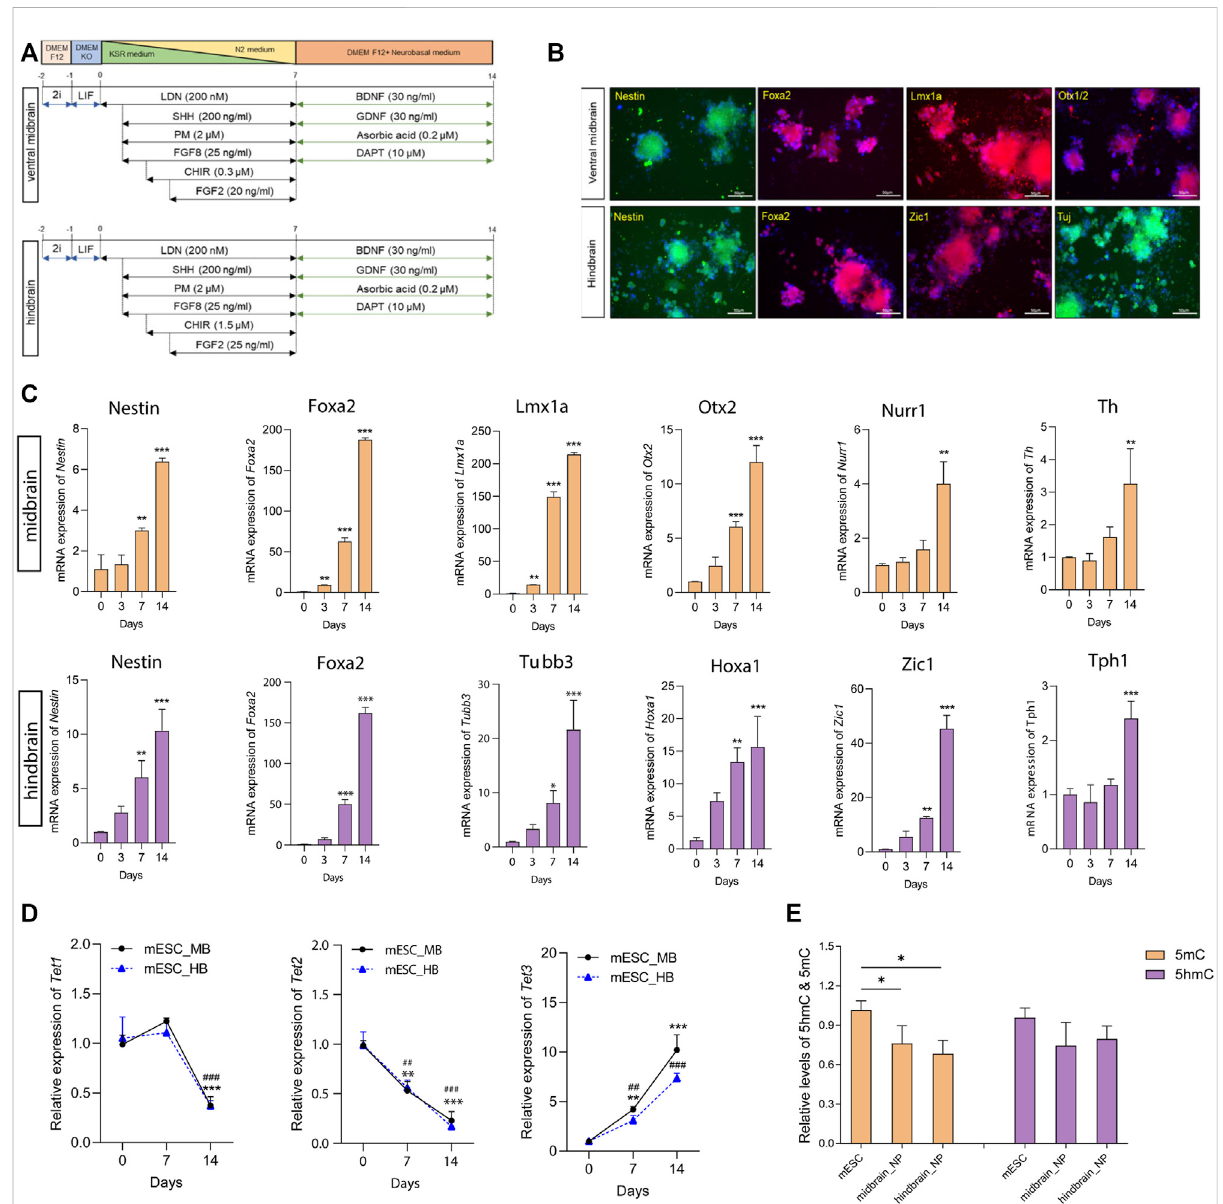
FIGURE 1 DifferentiationofmouseESCsintoventralmidbrainandhindbrainfate. (A) Aschematicoverviewoftheprotocolforthedifferentiationofmouse ESCinto ventralmidbrain(MB)and hindbrain (HB) progenitors. (B) Representativephotos depicting expression ofMB markers (Nestin, Foxa2, Lmx1a, and Otx1/2) and HB markers (Nestin, Foxa2, Zic1, and Tuj). (C) Transcriptional expression of speci fi c neuronal marks in MB and HB speci fi cations. (D) qRT-PCR of Tets in the three differentiation states. (E) Relative global 5mC and 5hmC levels in different differentiation states, measured by LC- MS/MS. All data are expressed as mean ± SD ( n = 3). * p < 0.05, ** p < 0.01, and *** p < 0.001; # p < 0.05, ## p < 0.01, and ### p <